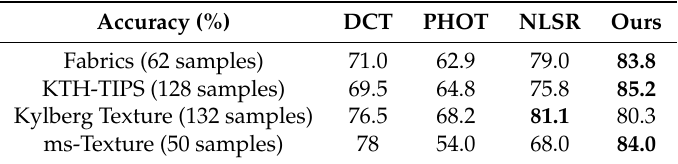
Table 4. Comparison of quantitative image-level defect detection results for the compared algorithms on the Fabrics, KTH-TIPS, Kylberg Texture and ms-Texture